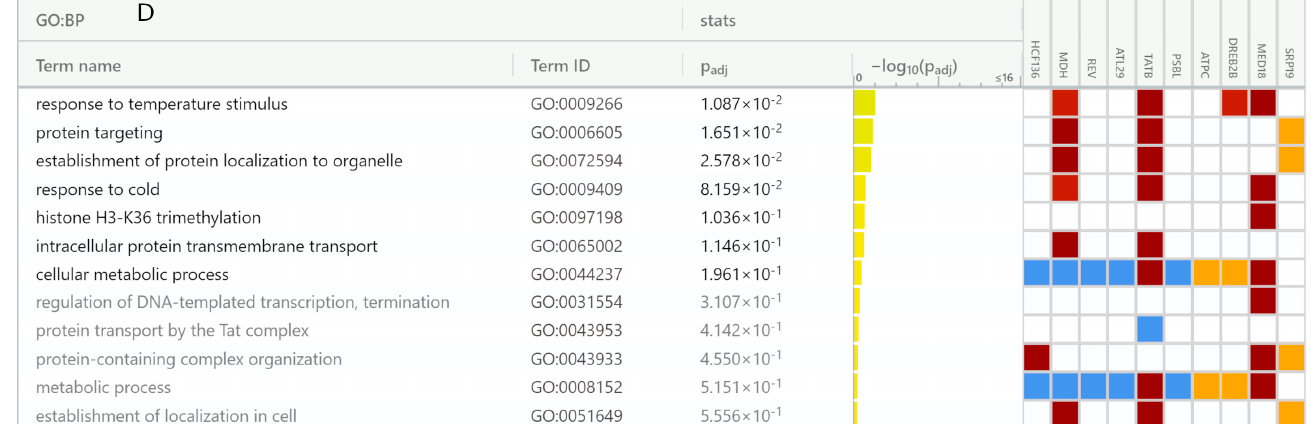
Figure 9. H. sapiens and A. thaliana gene set enrichment analysis of GIP-9-like motif-containing proteins. Human genes categorized in ( A ) molecular function terms and ( B ) biological process terms. A. thaliana genes categorized in ( C ) molecular function terms and ( D ) biological process terms. Color codes indicate data inferred from: dark brown—experiment/direct assay, light brown—genetic and physical interactions, yellow—sequence similarity, dark purple—high throughput experiment, green—curator, blue—reviewed computational data.